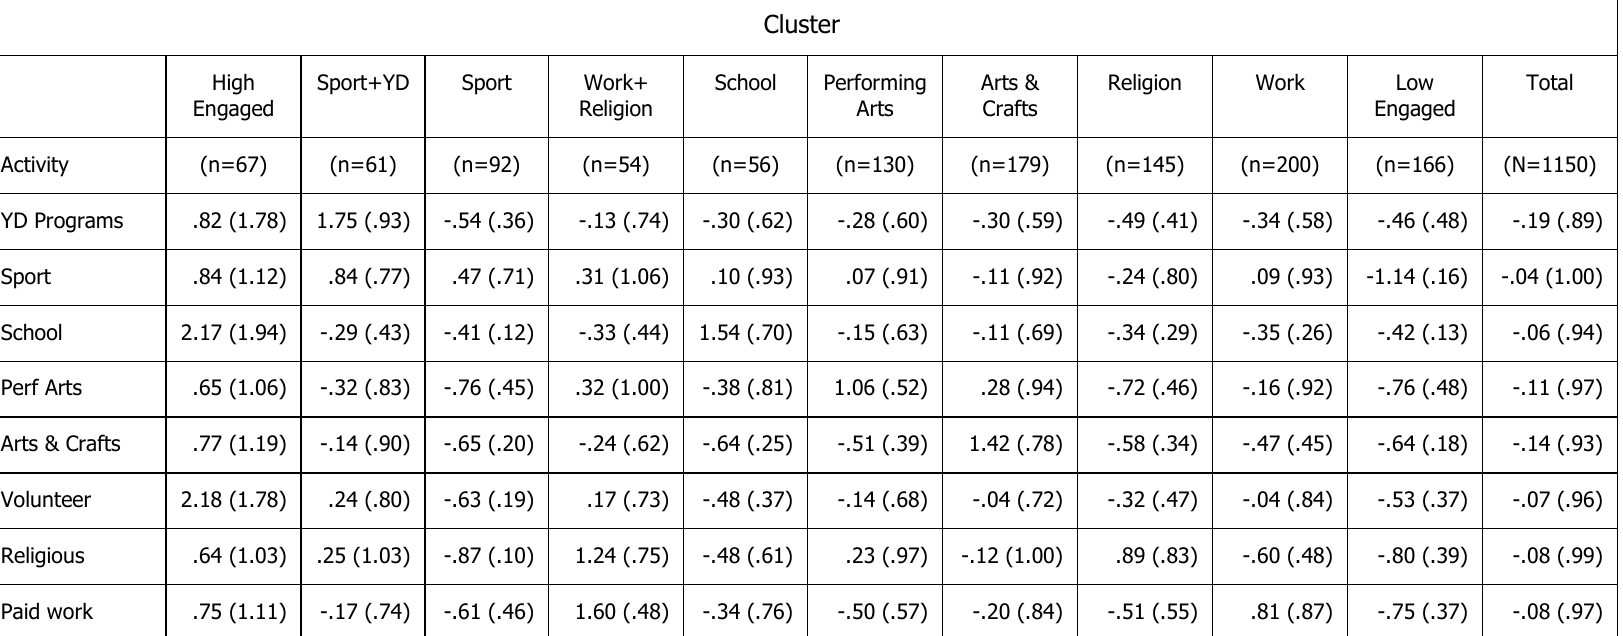
Means and Standard Deviations of Adolescents’ rate of participation in activities by 7 th Grade Activity Participation